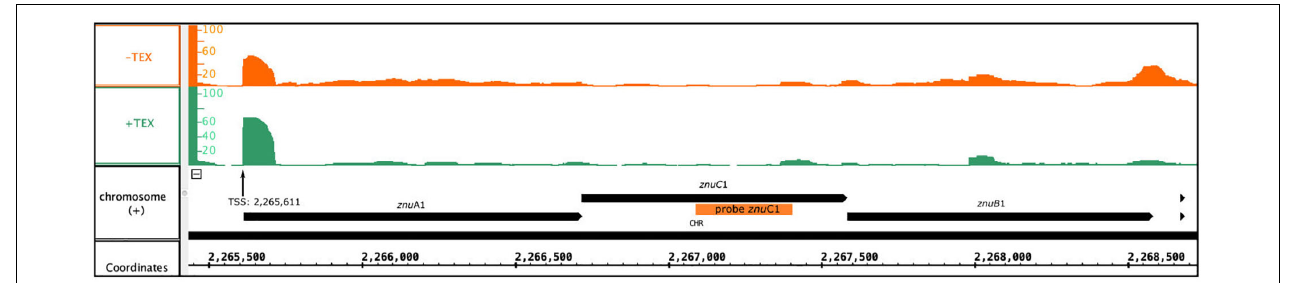
FIGURE 6 | Genomic localization of the znu operon. Depicted is the localization of the znu operon alongside the read coverage at TSS (Babski et al., 2016) confirming the joint transcription of all three znu genes as an approximately 3,000 nt transcript. The location of the PCR probe used for znu C1 detection in northern blot hybridization is given as orange bar. Reads obtained from RNA treated with terminal exonuclease (+TEX) are shown in green, and reads from untreated RNA ( − TEX) are shown in orange. Comparison of reads from both fractions allowed us to determine the TSS (indicated by an arrow). Genome coordinates and annotated genes of the main chromosome plus strand are shown in black at the bottom.